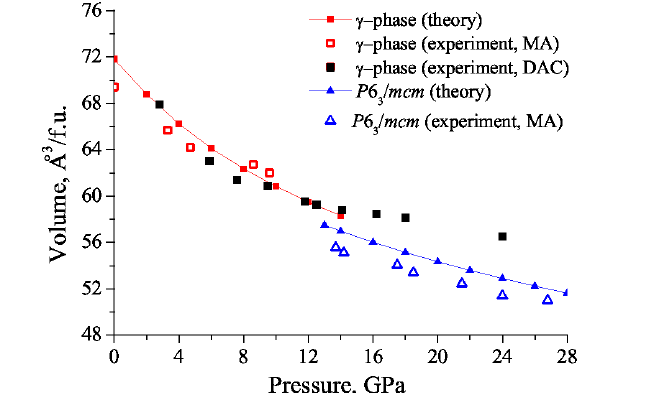
Figure 9. Theoretical and experimental pressure V(P) dependencies for γ - and P 6 3 / mcm phases of Na 2 CO 3 . Solid red and blue lines correspond to the EOSs of γ and P 6 3 / mcm phases determined by the theoretical points.